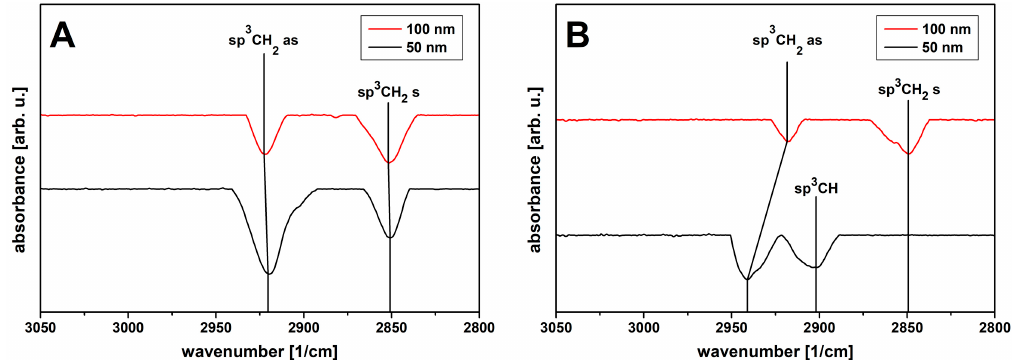
Figure 7. Diffuse reflectance infrared Fourier transform (DRIFT) spectra of the analyzed ( A ) CS and ( B ) CN–CS samples coated with a–C:H layers of 50 (black) and 100 nm (red).